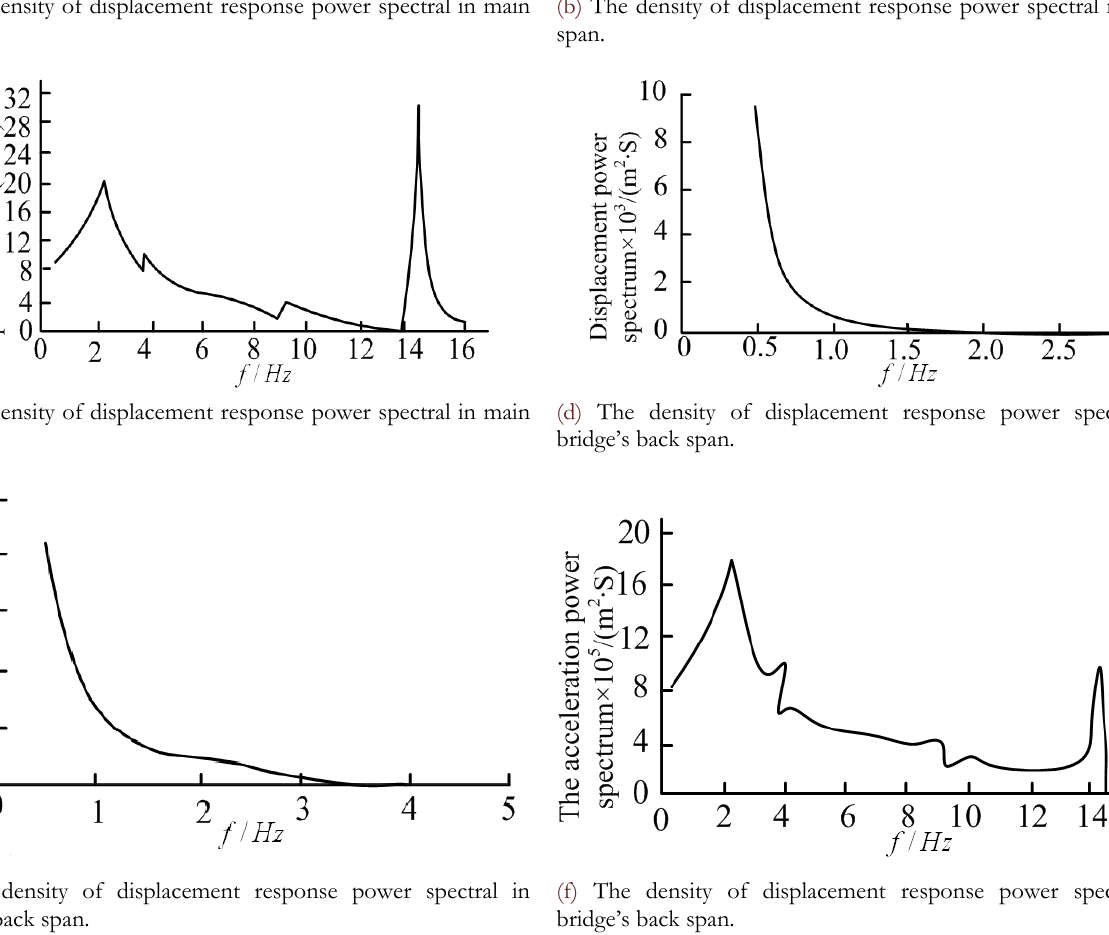
Figure 3 The response power spectral density of main span, mid-span across back in cable-stayed